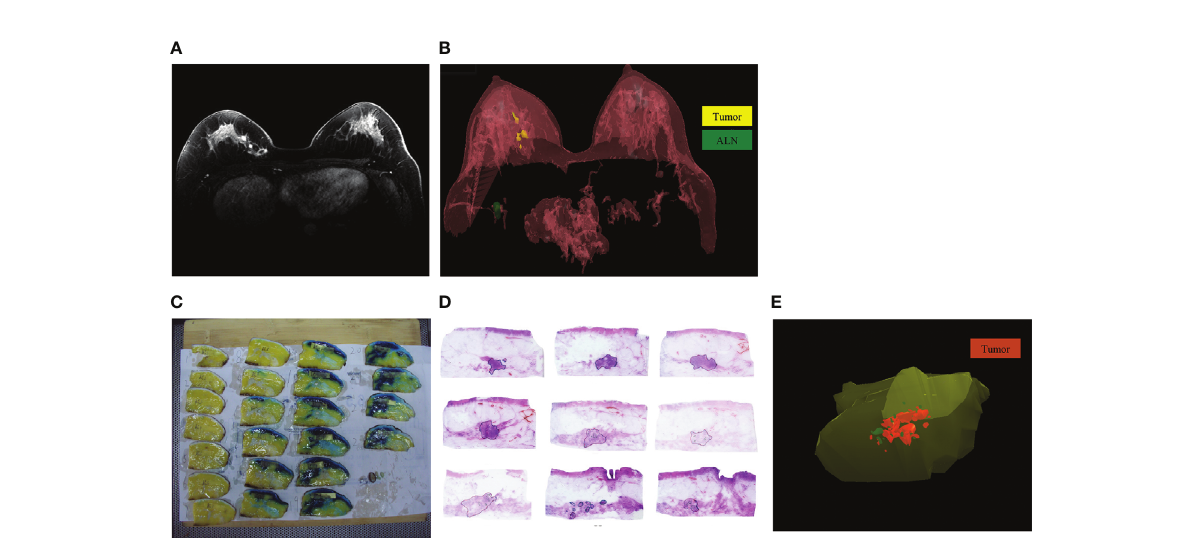
FIGURE 2 The MRI and pathology 3D reconstruction. (A) : The MRI imaging of residual tumor after NAT; (B) : The MRI 3D reconstruction model of residual tumor after NAT; (C) : The specimen was cut into several blocks at 5-mm intervals based on the markers; (D) : The extent of residual tumors was delineated under microscope; (E) : The pathology 3D reconstruction model of residual tumor after